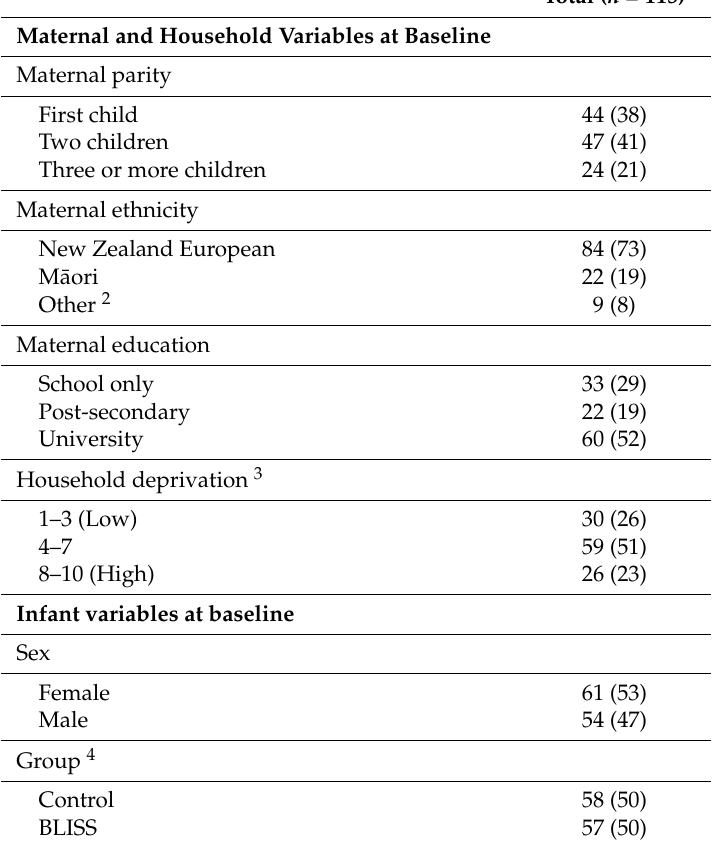
Table 1. Maternal and infant baseline characteristics of participants who provided plasma zinc data at 12 months of age 1 .